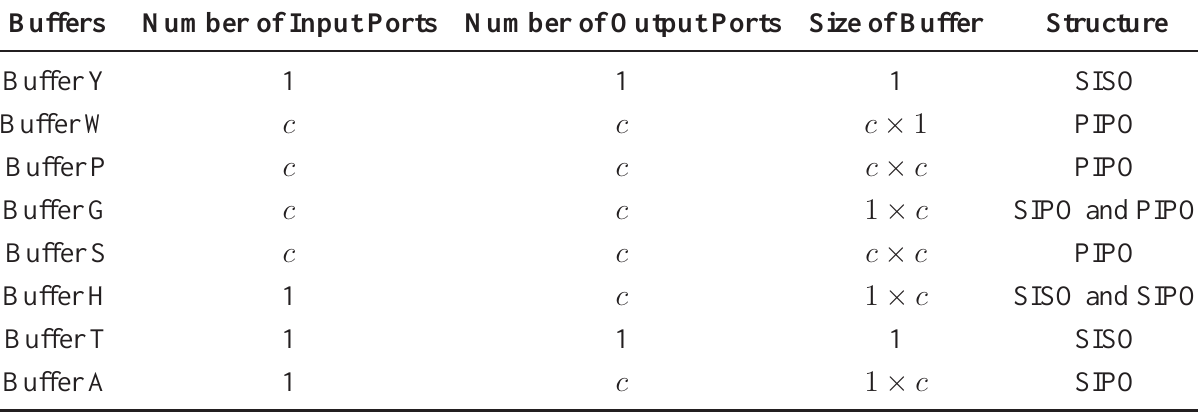
Table 1. The attributes of the buffers in the memory